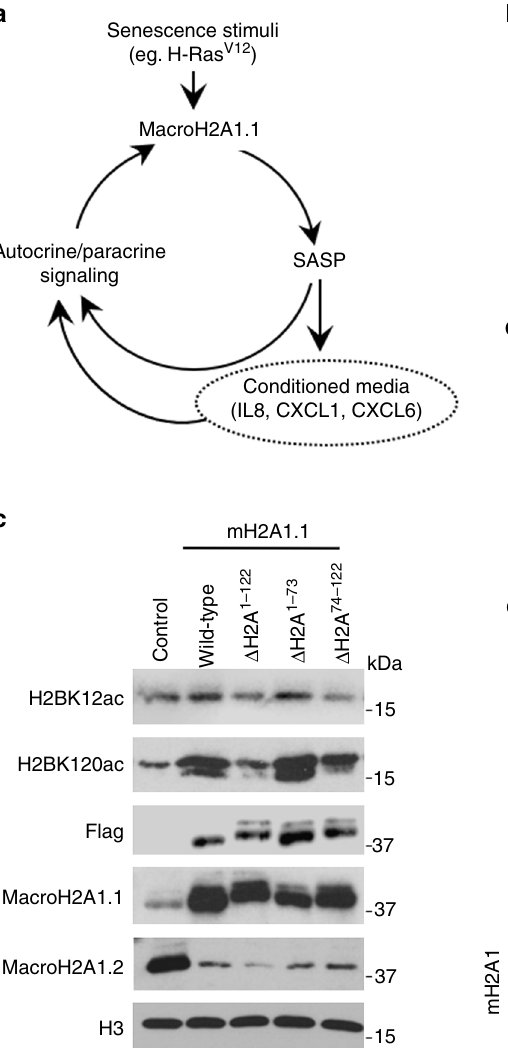
(Fig. 1f) as did a similar chimera lacking the macrodomain (Supplementary Fig. 2). Overall, this indicates that the carboxyl-